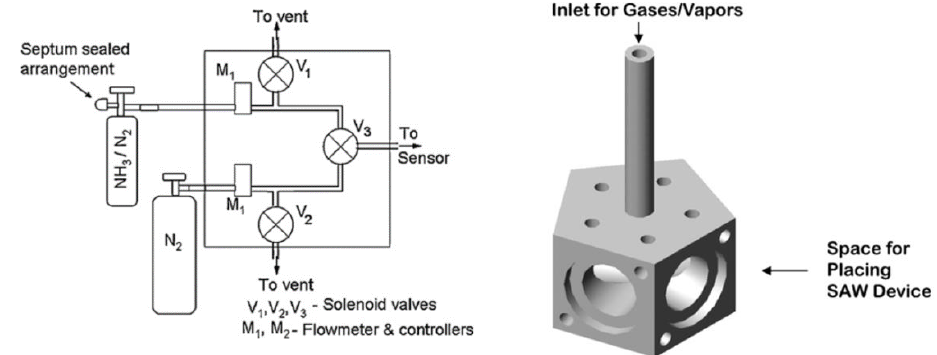
Figure 22. Schematic of the pentagon-shaped sensor cell and the gas delivery system [184].